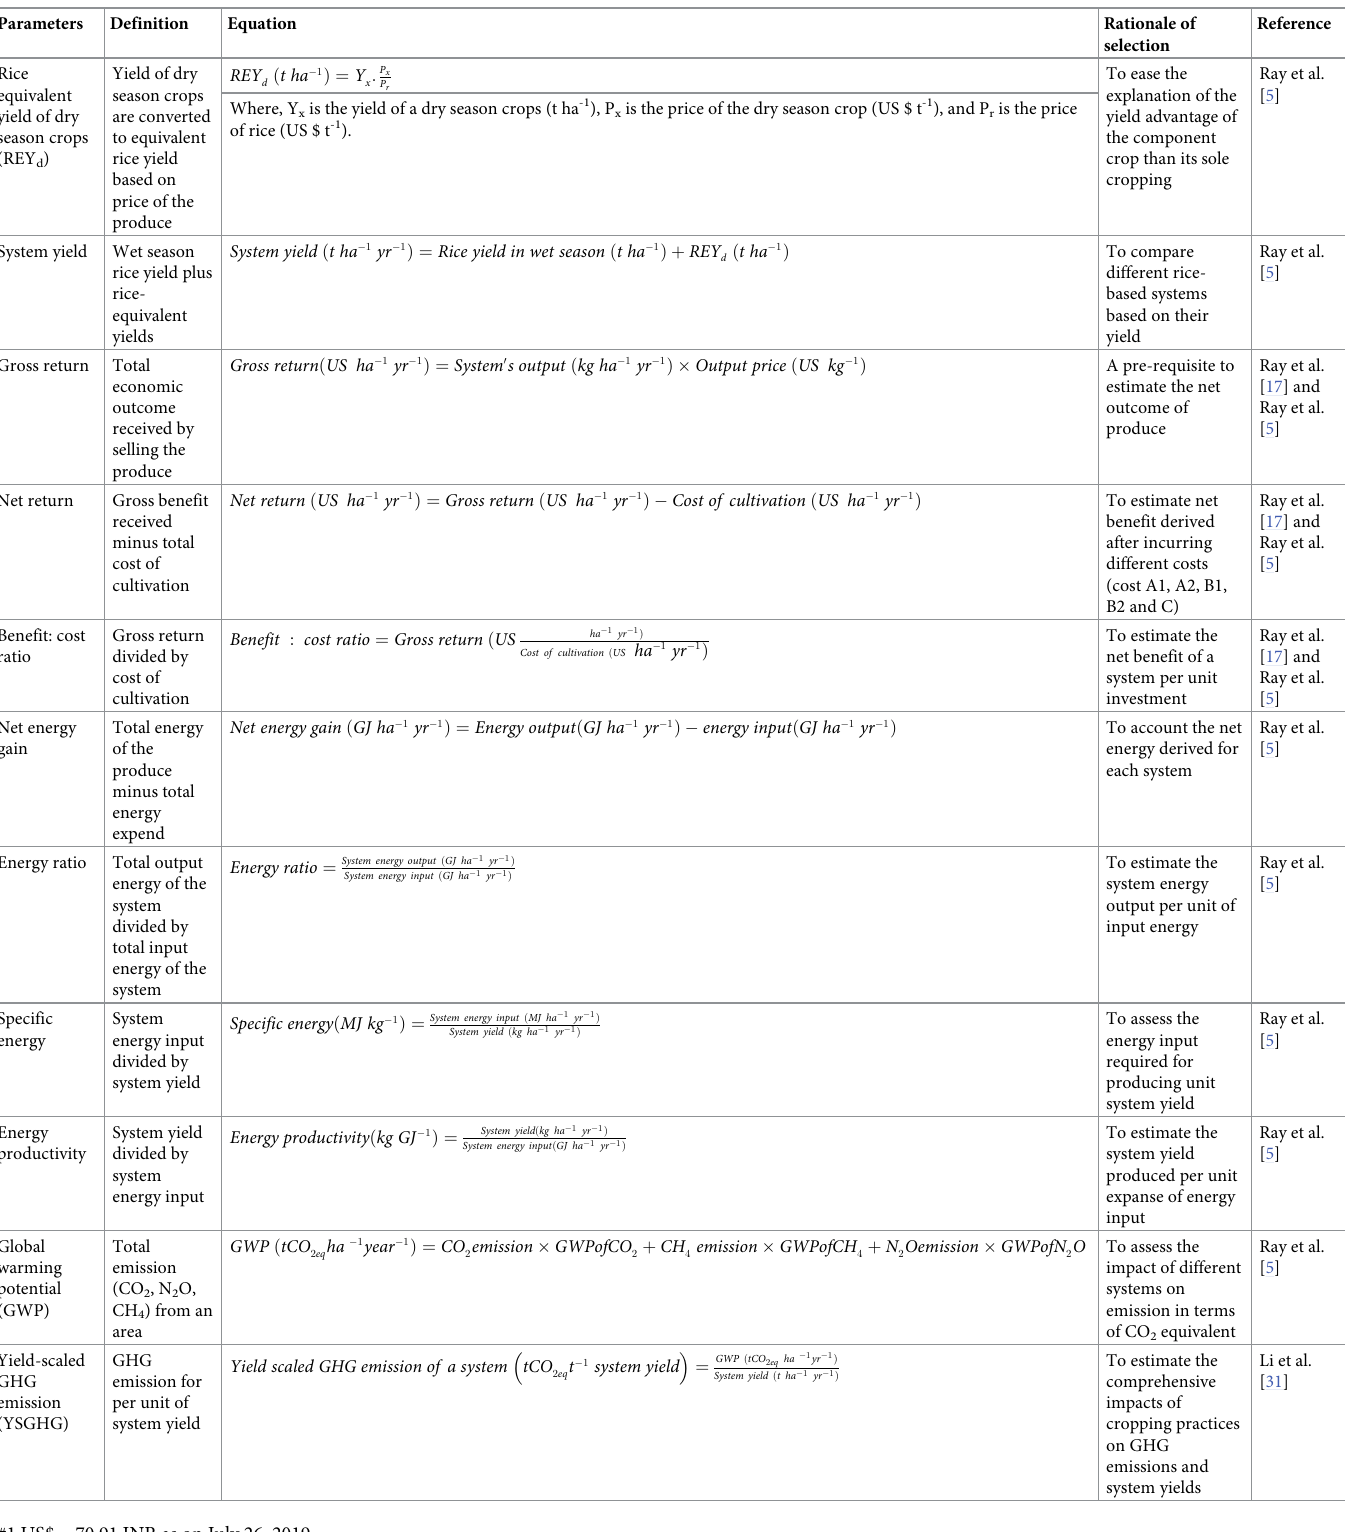
Table 1. Details of the parameters studied to estimate the productivity, profitability, energetic and GHGs emission of different rice-based cropping systems.